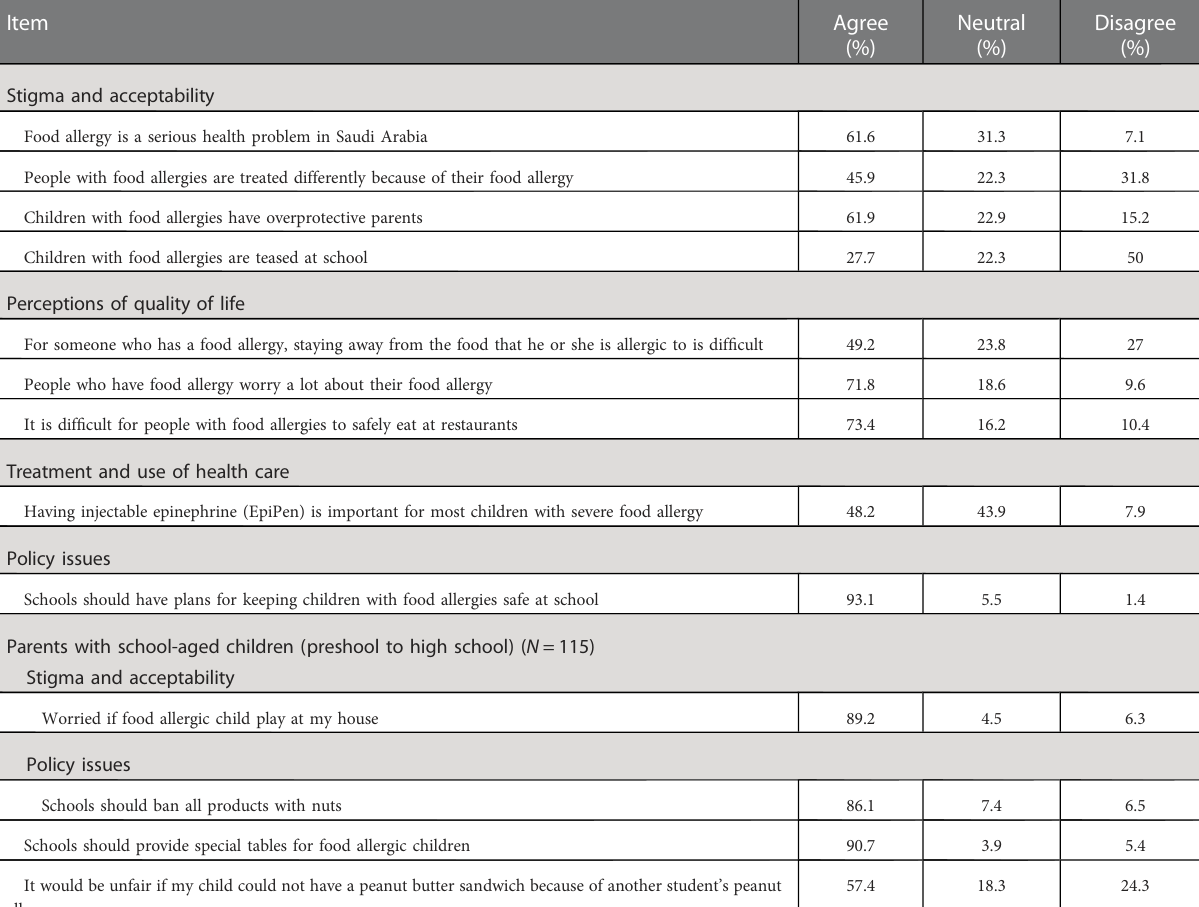
TABLE 4 Attitudes and beliefs (Likert